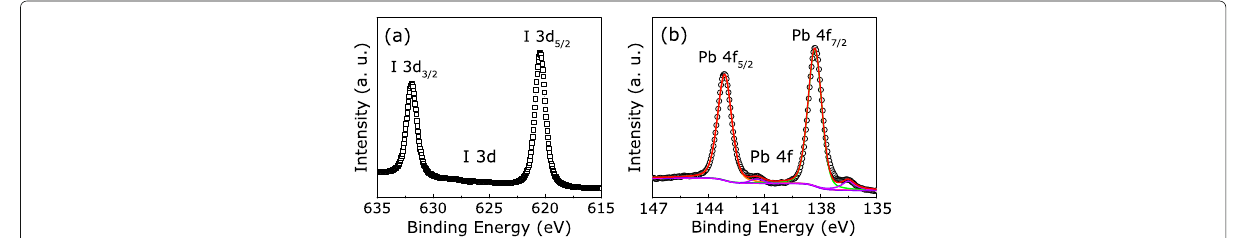
Fig. 6 XPS spectra of a I 3 d and b Pb 4 f core levels of the KCl-doped MAPIC